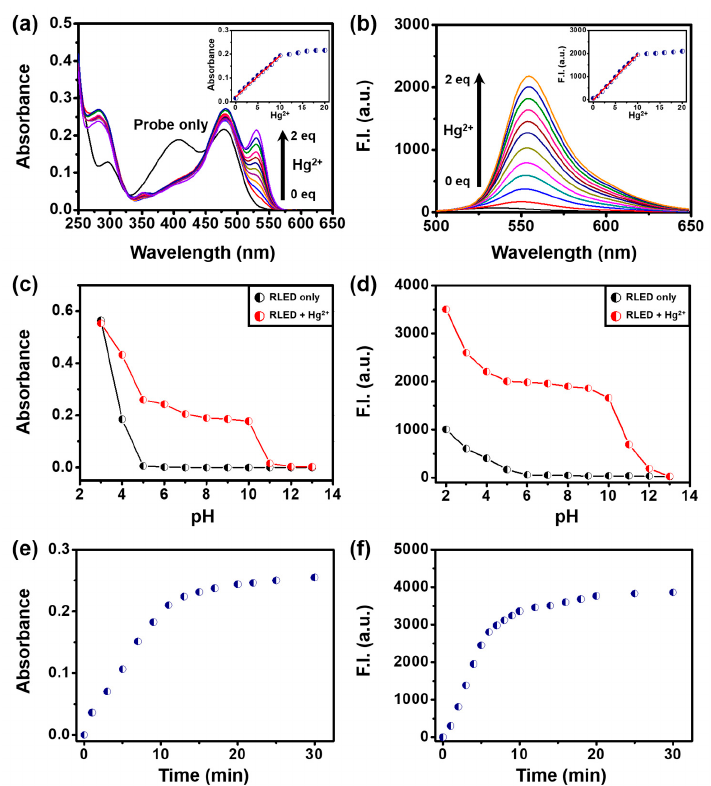
Figure 1. ( a ) Absorbance spectra of RLED (10 µ M) in MeOH/HEPES (pH 7.4; 1/9; v / v ) at 25 ◦ C upon increasing the addition of Hg 2+ (0, 0.1, 0.2, 0.3, 0.4, 0.5, 0.6, 0.7, 0.8, 0.9, 1.0, and 2.0 equivalents) (inset: absorbance at 530 nm vs. the concentration of Hg 2+ and their linear fitting curve). ( b ) Emission spectra of RLED (10 µ M) in MeOH/HEPES (pH 7.4; 1/9; v / v ) at 25 ◦ C upon the gradual addition of Hg 2+ (0, 0.1, 0.2, 0.3, 0.4, 0.5, 0.6, 0.7, 0.8, 0.9, 1.0, and 2.0 equivalents); excitation wavelength: 530 nm (inset: emission intensity at 558 nm vs. the concentration of Hg 2+ and their linear fitting curve). All of the spectra were recorded 30 min after the Hg 2+ addition. ( c ) An absorbance intensity at 530 nm and ( d ) fluorescence intensity at 558 nm of free RLED (10 µ M) and RLED +1 equivalent Hg 2+ in MeOH/H 2 O (1/9; v / v ) with different pH conditions for 30 min. ( e ) Changes of absorbance at 530 nm and ( f ) fluorescence intensity at 558 nm of RLED (10 µ M) upon the addition of 1–5 equivalent of Hg 2+ in MeOH/H 2 O (1/9; v / v ) with the